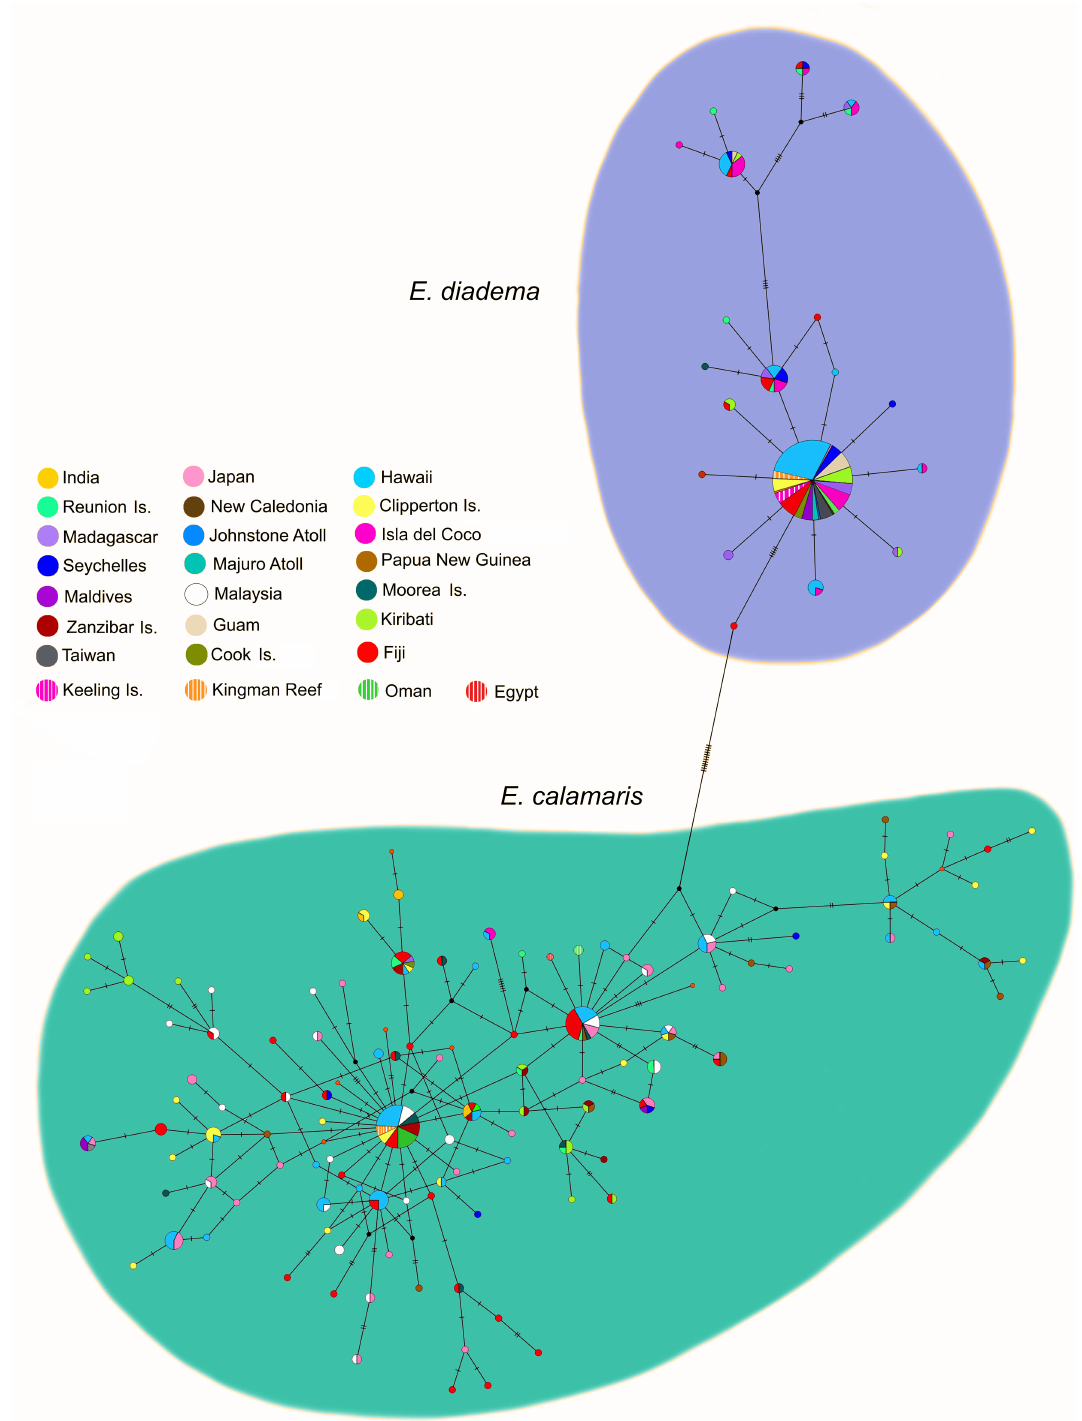
Figure 5. Median joining haplotype network based on 28S rDNA and intron of Calpain-7 nuclear DNA. Constructed in PopART with reticulation tolerance set to Pairwise AMOVAs for E. calamaris clade 1 demonstrated significant genetic differentiation in mtDNA between populations in the tropical eastern Pacific and those of the Indian Ocean ( Φ CT value = 0.455, p = 0.029), but not between the eastern Pacific and populations in the Hawaiian Archipelago Φ CT value = − 0.051, p = 0.489), the central Pacific ( Φ CT value = 0.305, p = 0.150) or western Pacific ( Φ CT value = 0.558, p = 0.345) (Table 4). The populations in the Hawaiian Archipelago showed significant inter-regional mtDNA differences with those in the Indian Ocean ( Φ CT value = 0.462, p = 0.007). They also had a high percentage of significant regional variation with populations in the rest of the central Pacific (33.60%, Φ CT value = 0.336, p = 0.032), but were